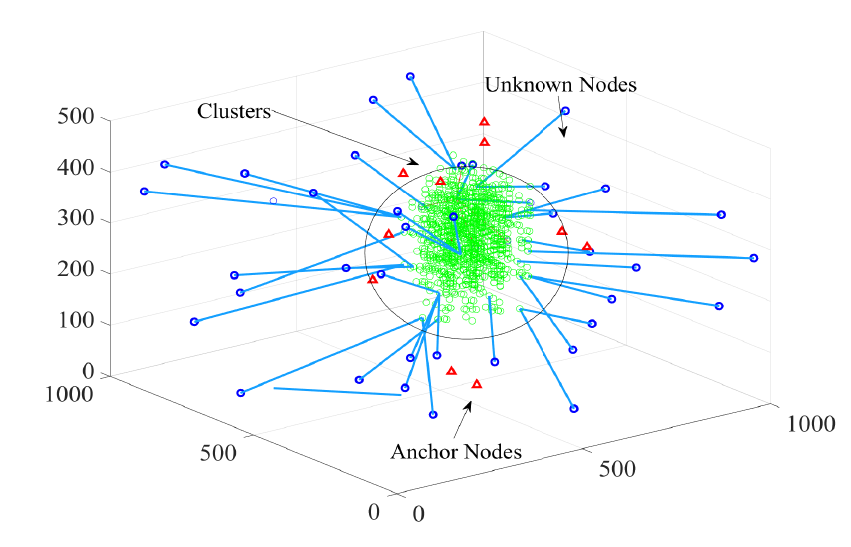
Figure 6. Selection of clusters based on CC values, V = 100 and N =